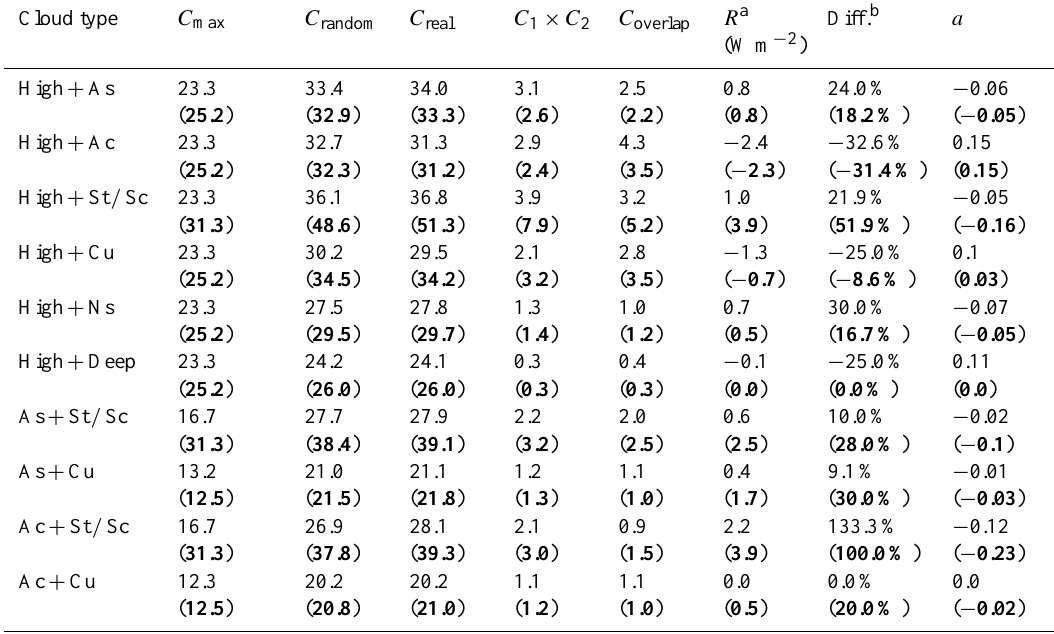
Table 3. Cloud fractions of different multilayered cloud types based on different overlap assumptions and observations during daytime. Here, C overlap and C 1 × C 2 are the overlap cloud fractions from observations and overlap assumptions. “ a ” presents the overlap